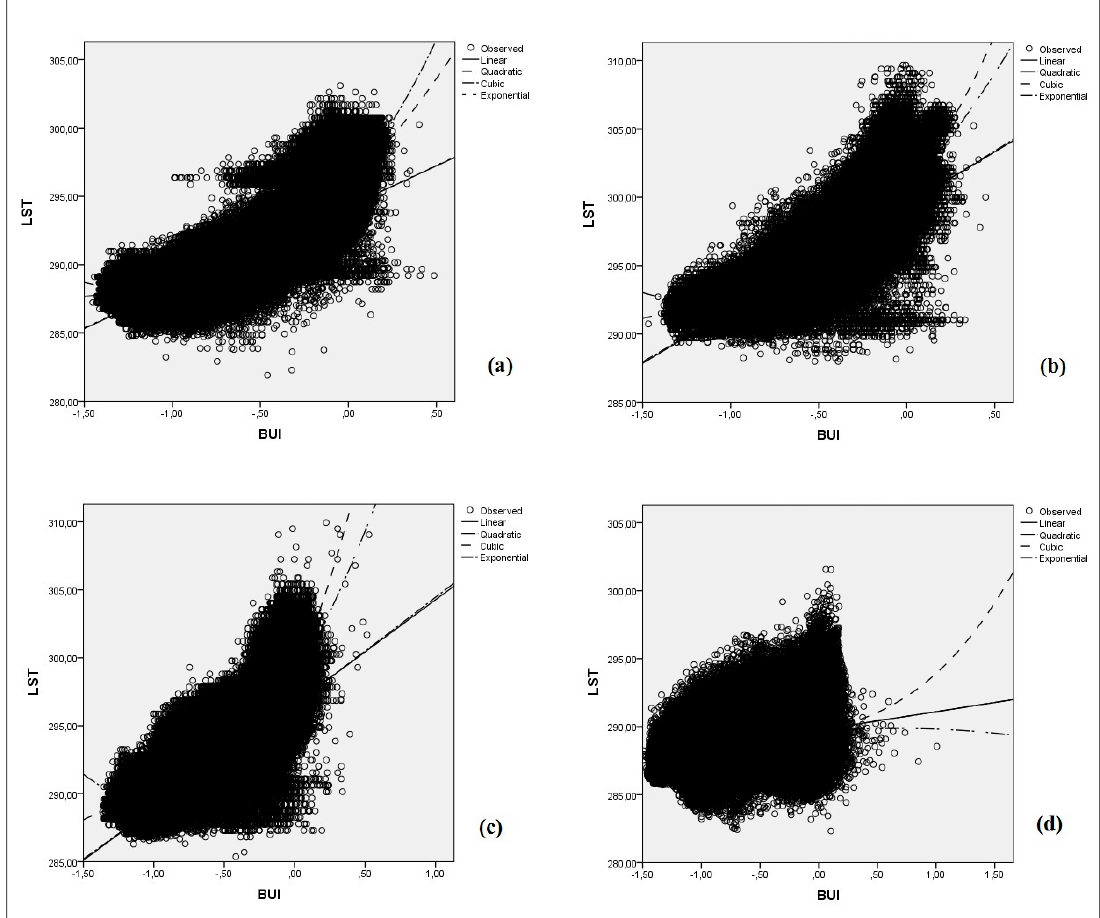
Figure 7. Correlation study between LST and BUI: ( a ) 7 February 1987 BUI/LST correlation study (R² = 0.847); ( b ) 8 February 2002 BUI/LST correlation study (R² = 0.865); ( c ) 8 January 2011 BUI/LST correlation study (R² = 0.849); and ( d ) 3 January 2015 BUI/LST correlation study (R² = 0.322).